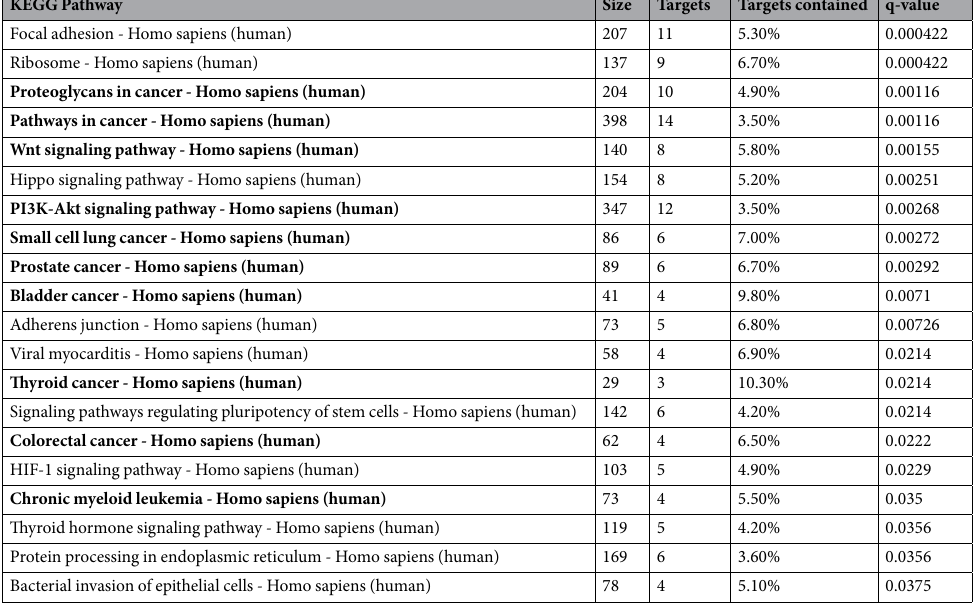
Table 2. Associated KEGG pathways from inversely correlated target gene expressions. Cancer related pathways are marked in